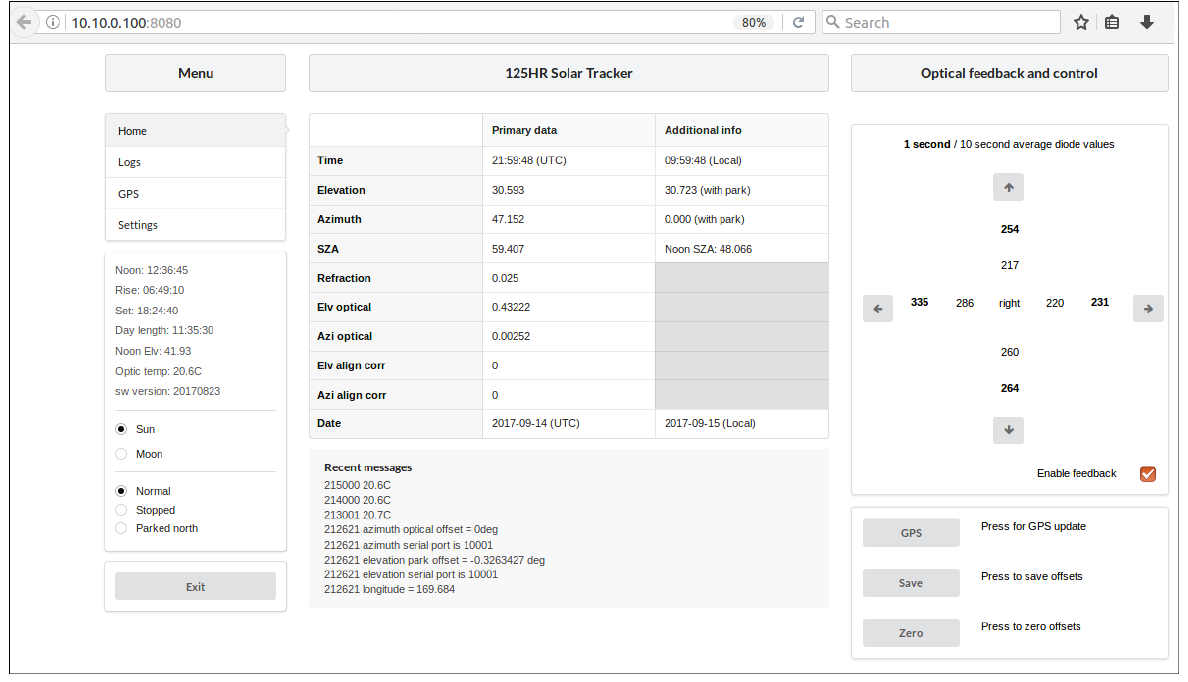
Figure 6. The web server user